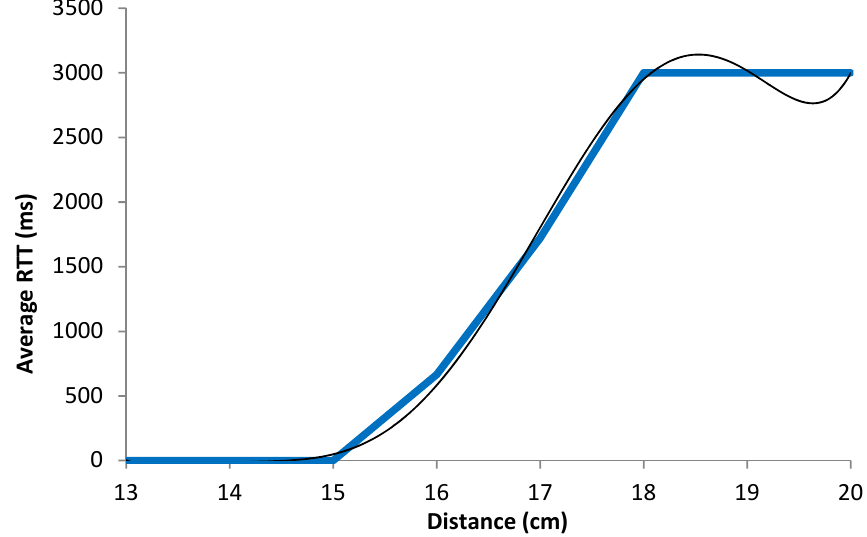
Figure 22. Average RTT for 11